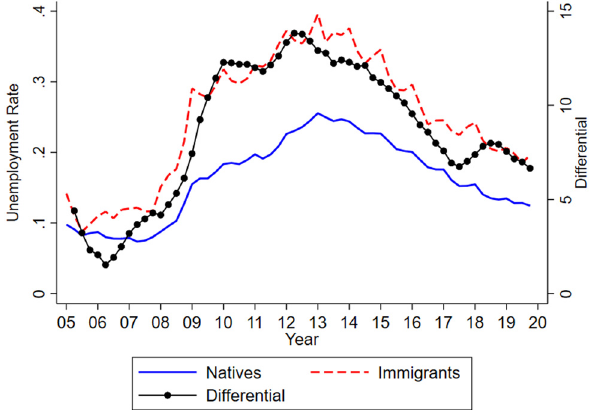
Figure 3: Unemployment rate by nationality. Note: The unemploy - ment rate di ff erential ( plotted in the right y - axis ) is computed as the di ff erence between the natives ’ and immigrants ’ unemployment rate. Source: Spanish Labour Force Survey.